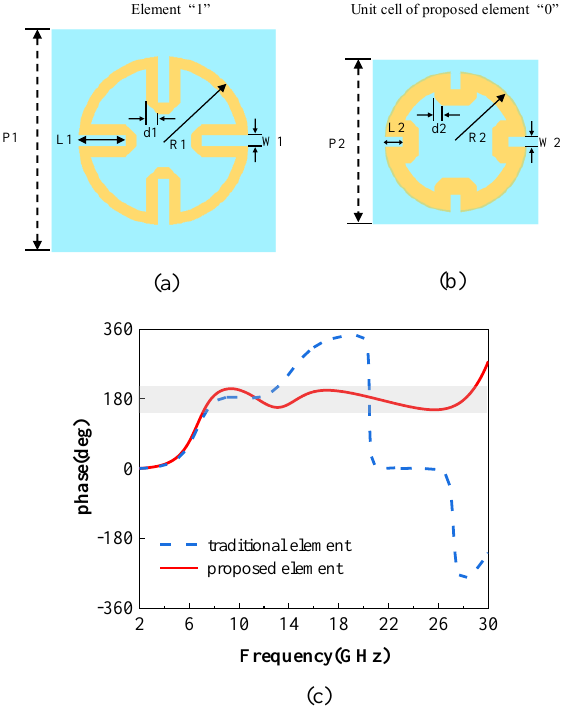
Figure 2. The proposed period-changed coding element and phase difference. ( a ) Dimensions of the “1” element, ( b ) dimensions of the “0” unit cell of the proposed period-changed “0” element (dimensions: P1 = 10 mm, P2 = 5 mm, w1 = 0.5 mm, w2 = 0.3 mm, d1 = 0.5 mm, d2 = 0.25 mm, R1 = 3.8 mm, R2 = 2.15 mm, l1 = 2.09 mm, l2 = 0.54 mm), and ( c ) phase difference of traditional coding elements and proposed period-changed coding elements.